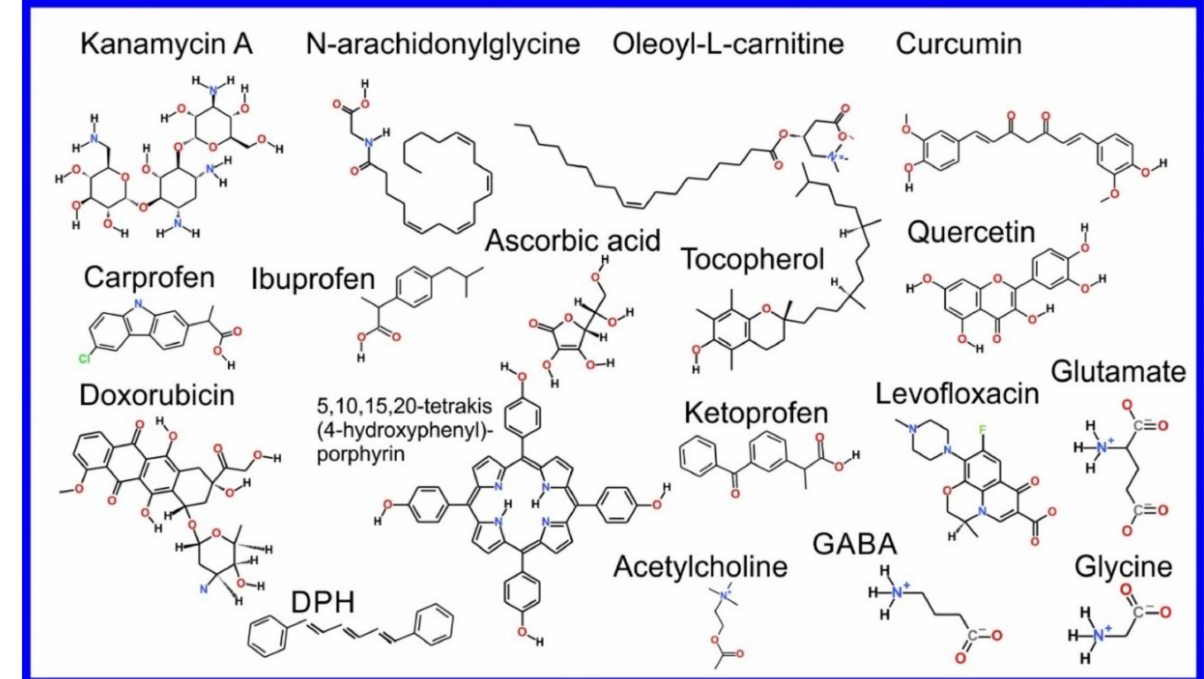
Figure 6. Chemical structure of drugs introduced in Section